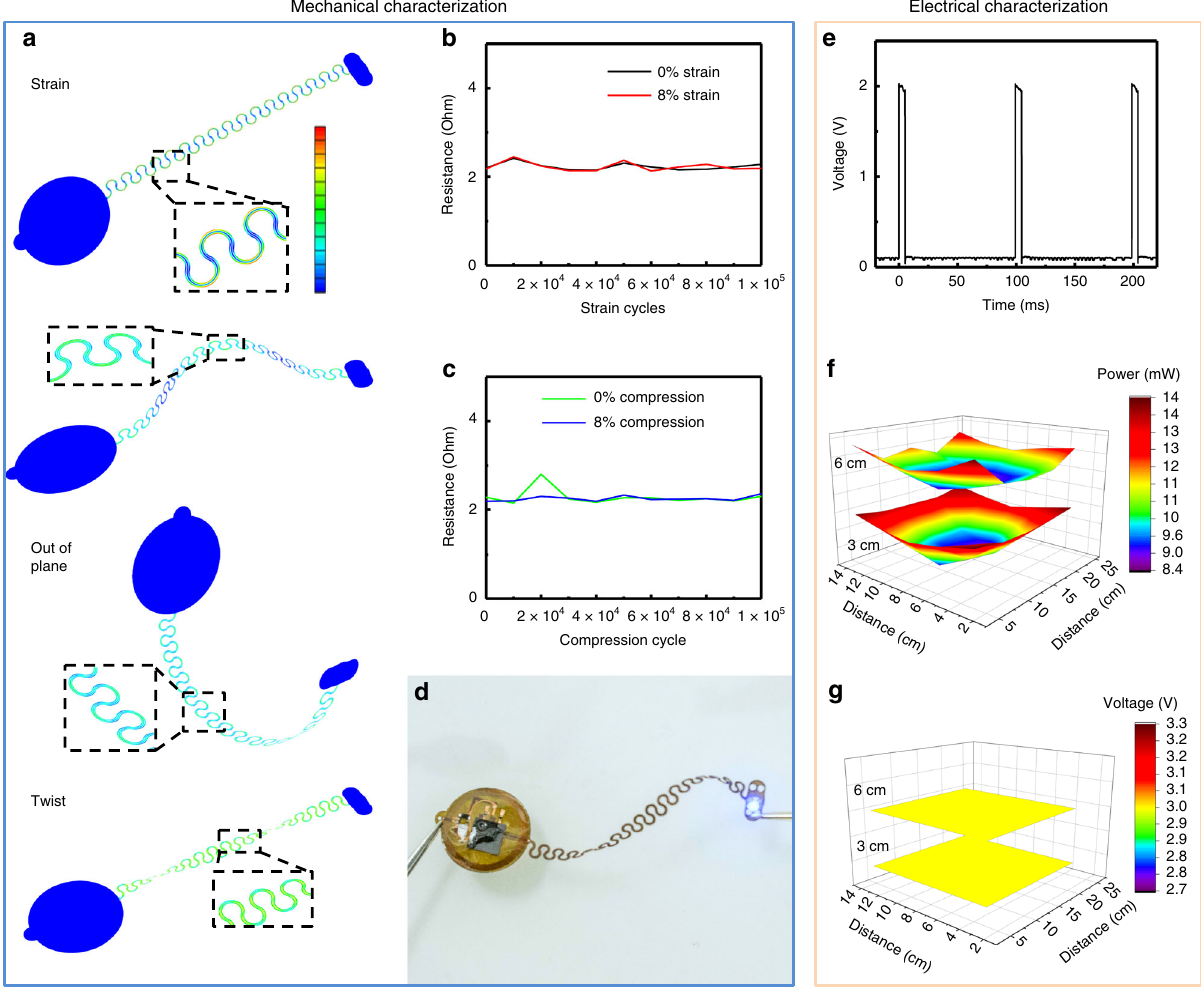
Fig. 2 Mechanical and electrical characterization results. a Finite-element simulation results for b 100,000 cycles of uniaxial tensile strain between 0 and 8%, with resistance measurements. c 100,000 cycles of uniaxial buckling from compressive strains between 0 and 8% stain. d Photographic image of a twisted device with activated optogenetic stimulator (scale bar 10 mm). e Time-resolved voltage of pacing electrodes. f Spatially resolved wireless resonant power in a test cage. g Spatially resolved regulated voltage with device the anterior epicardial surface of the left and right ventricles of a rat model independently. Figure 3b illustrates capabilities with representative stimulation patterns. Here an activation pattern with a frequency of 10 Hz and time duration of 5 ms appears with either electrode 1 or 2 and in conjunction. Accurate timing enabled by the µC also allows for asynchronous pacing with frequency and duty cycles chosen with microsecond precision.